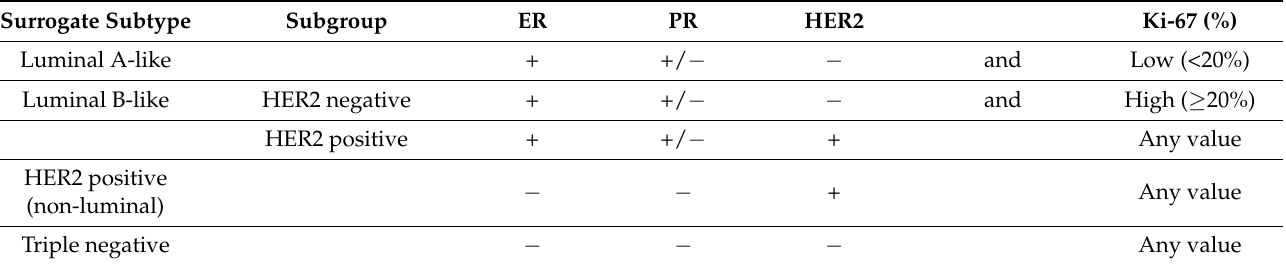
Table 4. Criteria for surrogate IHC subtyping according to [16].